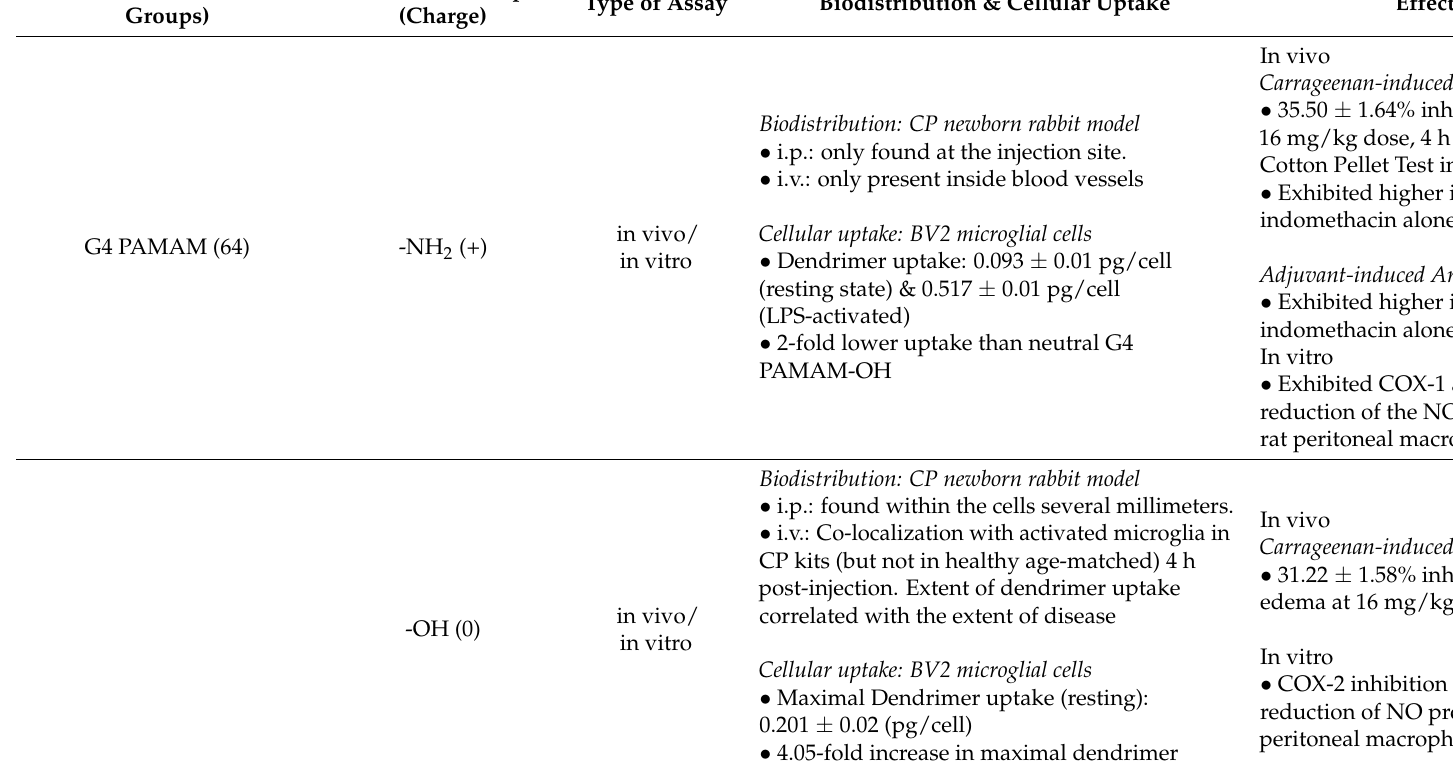
Table 2. Anti-inflammatory properties and uptake of dendritic structures by inflammatory cells. Dendrimer (No.